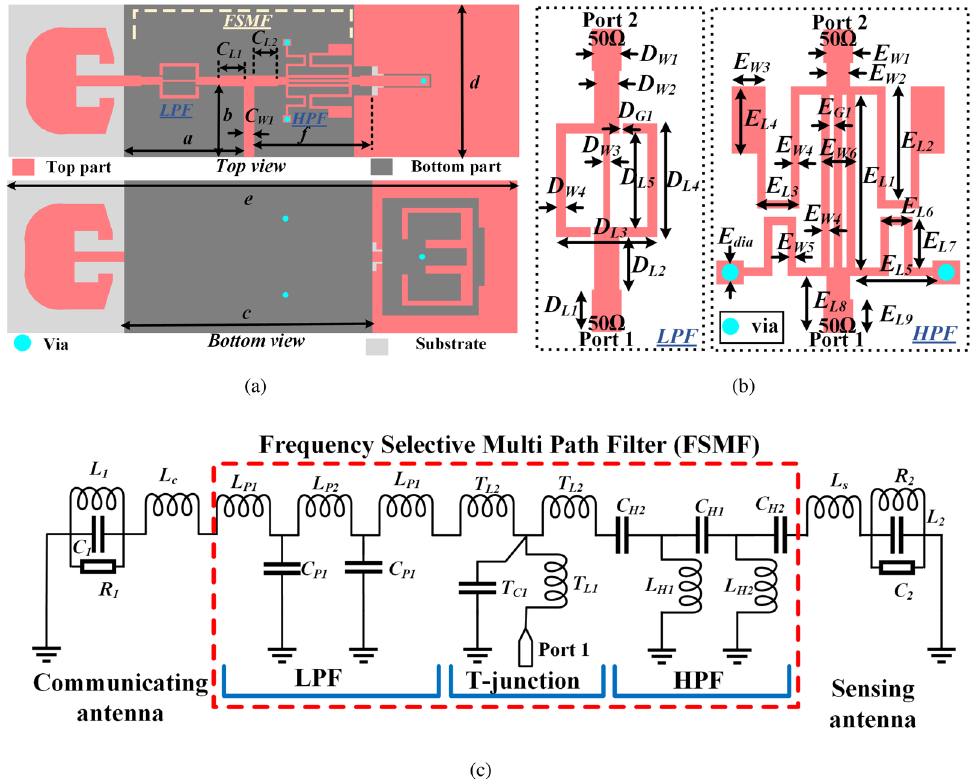
Figure 3. ( a ) Top and bottom view of the proposed dual-functional system, ( b ) dimensions of the LPF and HPF integrated into the FSMF of the proposed system, and ( c ) Equivalent circuit of the proposed dual-functional